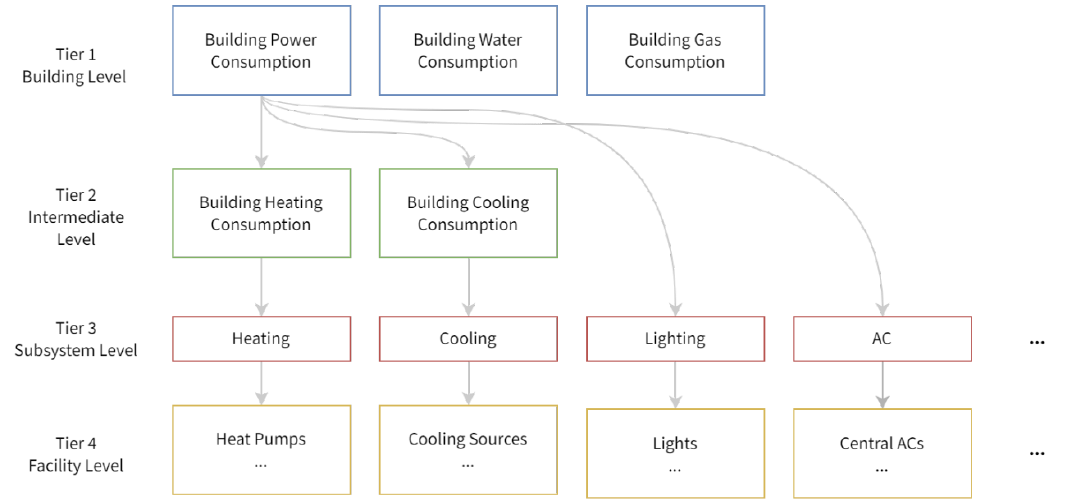
Figure 2. Illustration of the hierarchy of the building energy consumption data model.